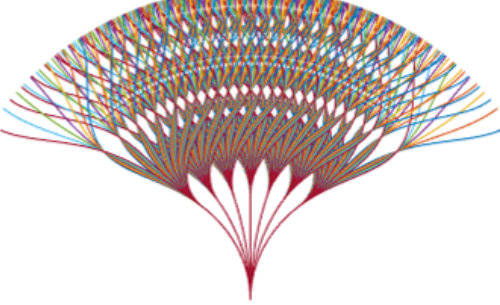
Figure 11. Generation results of sampling-based Free